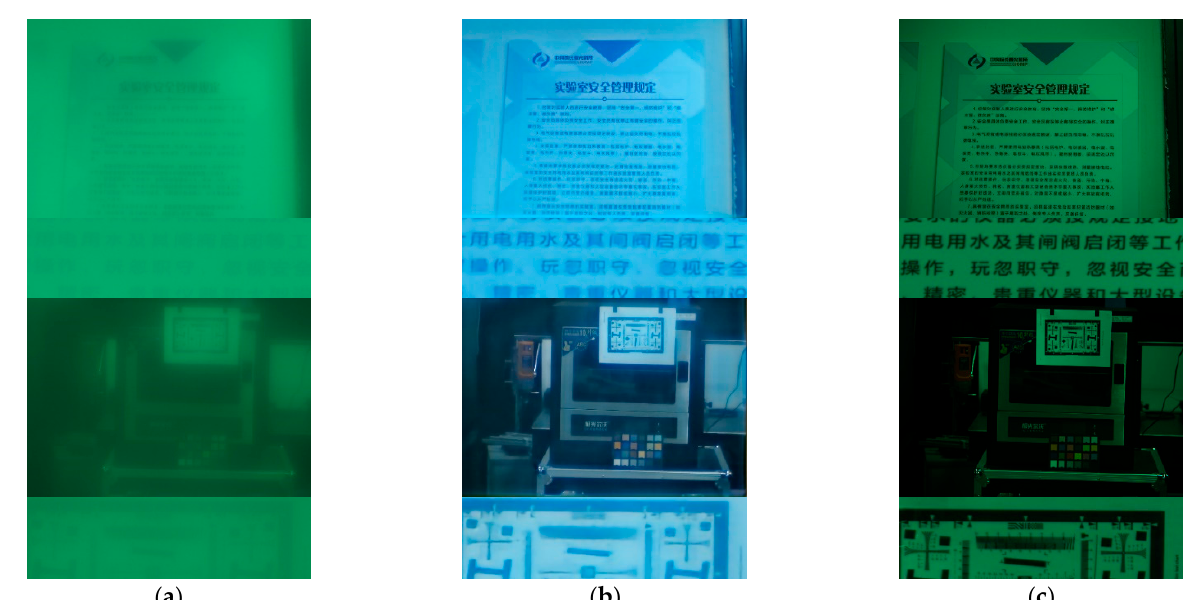
Figure 12. Imaging effect comparison with SLR camera lens: ( a ) Images directly captured by single-convex-lens imaging system; ( b ) The restoring images processed by our restoring method; ( c ) Images directly captured by conventional SLR camera lens.